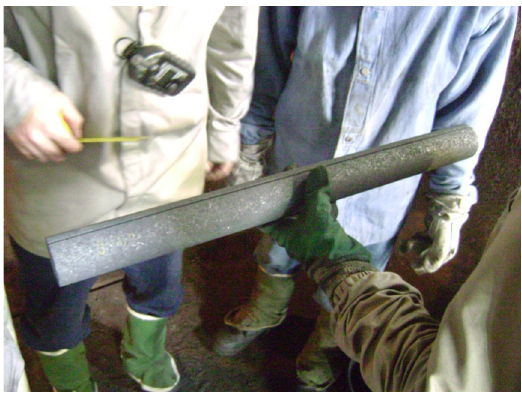
Figure 3. New refractory cylinder to restore the sample hole into the refractory